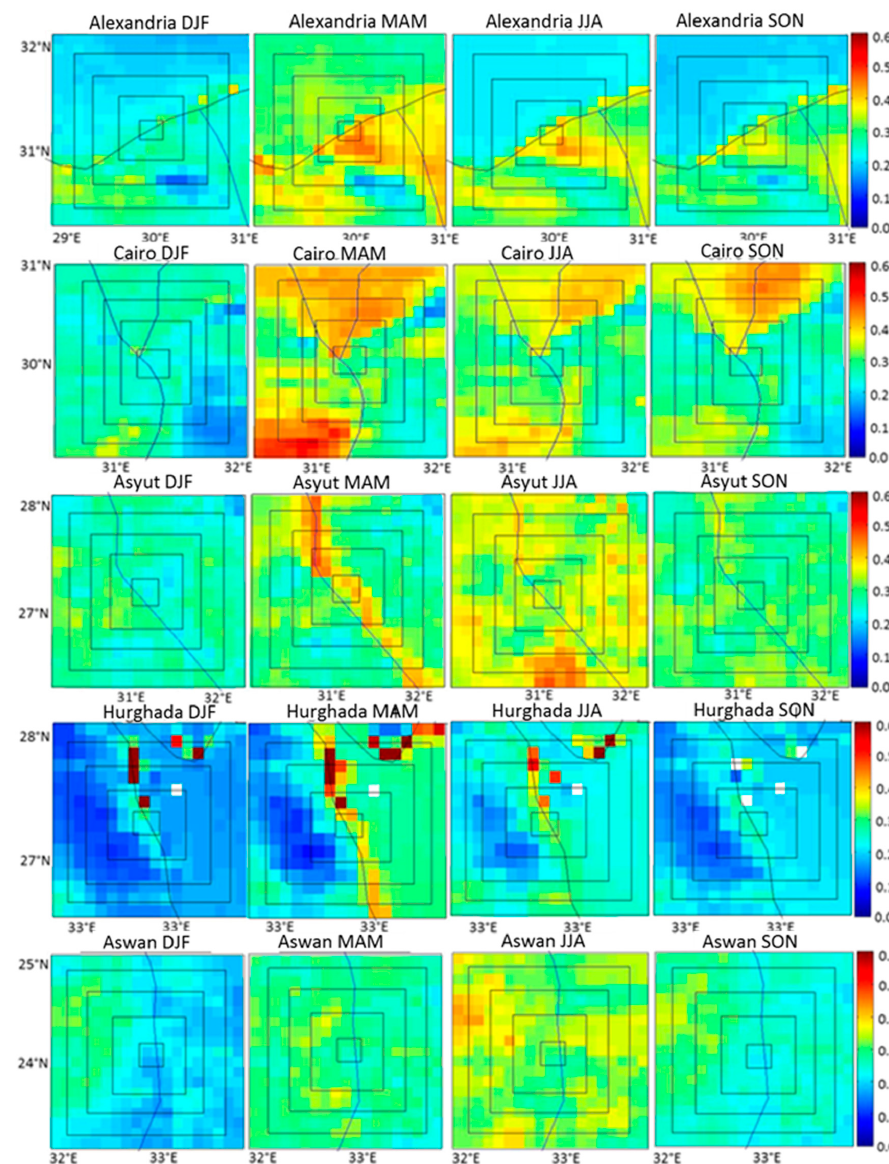
Figure 9. Spatial maps of seasonal average of AOD over the five urban areas. The size of each tile is 200 × 200 km 2 centered at the core of the city. Boxes inside each tile represent approximate boundaries of 20 (inner box), 50, 100, and 150 km. White pixels indicate insufficient data for averaging. Lines in blue are the path of the River Nile.